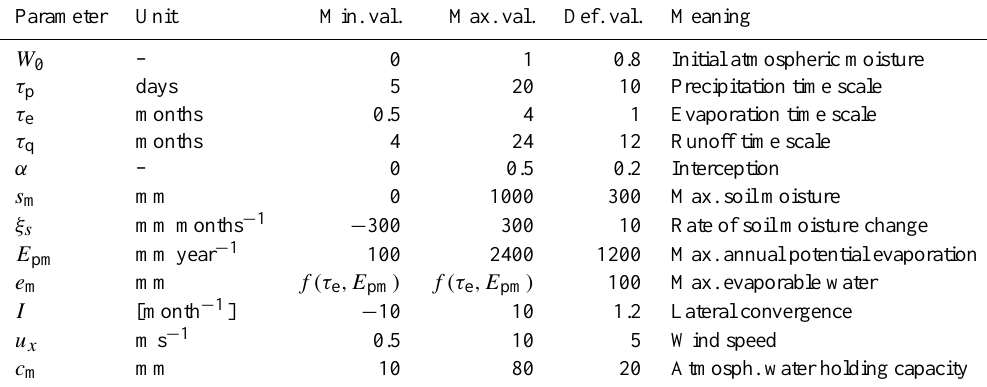
Table 2. Order of magnitude of parameter values used for numerical applications and default values used if nothing else is stated. The value for e m is obtained based on estimates of the maximum annual potential evaporation, E pm , as e m = τ e E pm .